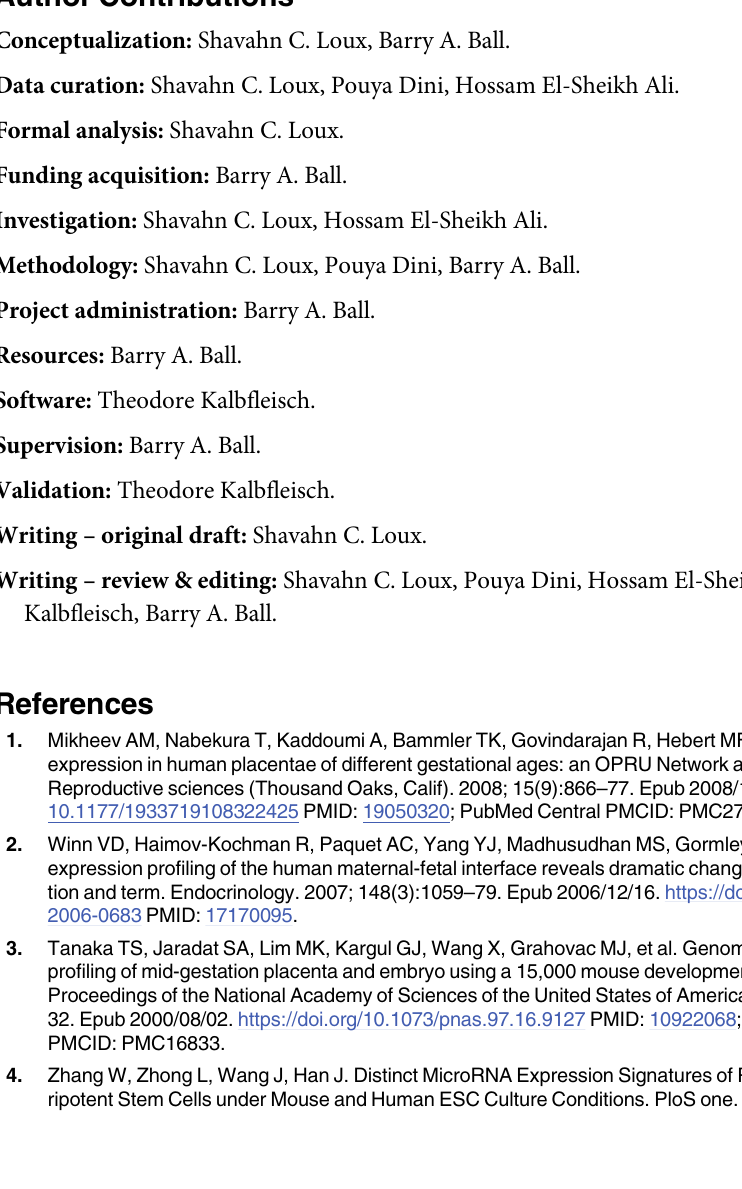
S6 Table. WGCNA analysis for endometrium. Each tab represents a separate module, including module correlation to gestational age and associated P-value, the list of genes included in the module and pathways identified by PANTHER Go Biological Process Com- plete for the genes included in each module (if